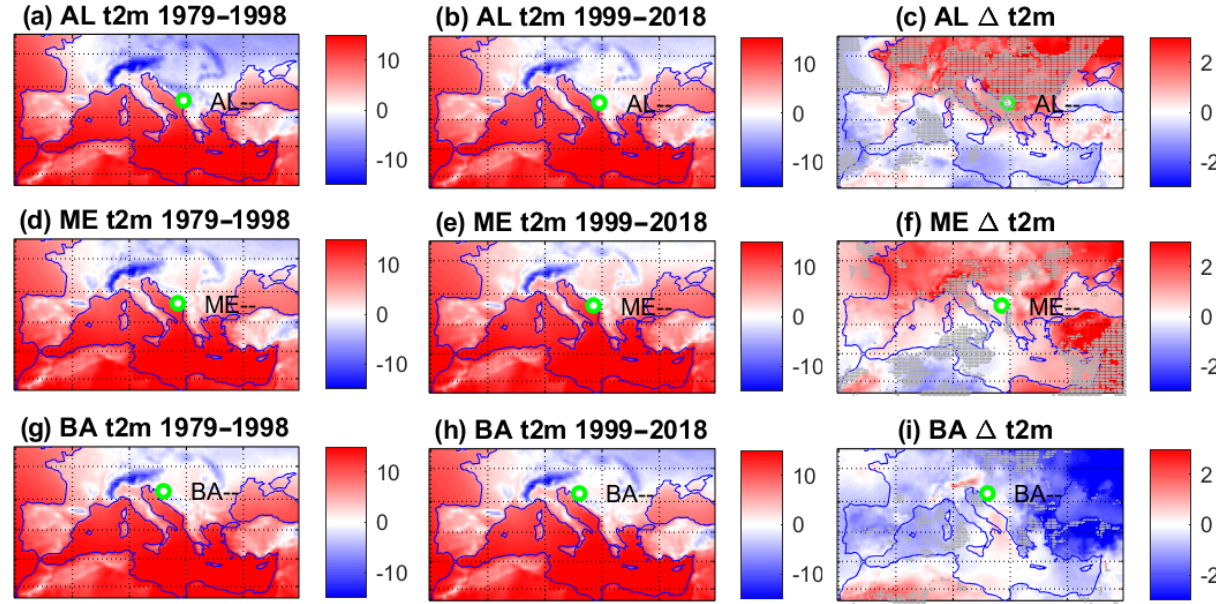
Figure 8. Average of 2m temperature fields ( ◦ C) during days of yearly maximum snowfall for the periods 1979–1998 (a, d, g) and 1999– 2018 (b, e, h) . Panels (c) , (f) and (i) show the differences between the second and the first periods ( (cid:49) t2m). (a, b, c) Albania (AL), (d, e, f) Montenegro (ME), (g, h, i) Bosnia (BA). Green circles show the location of the northwesternmost point of each country. Shaded areas represent grid points where at least two-thirds of the anomalies have the same sign.